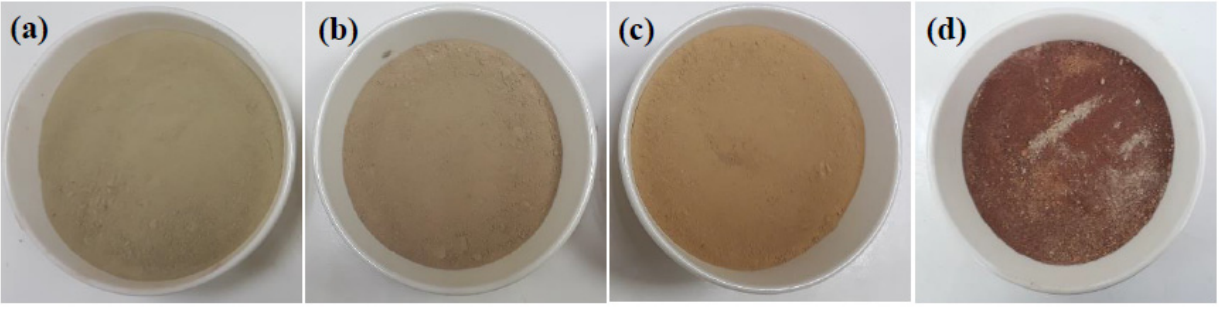
Figure A2. The images of ( a ) DM, ( b ) HM, ( c ) SM, and ( d ) the powder form of brick waste.